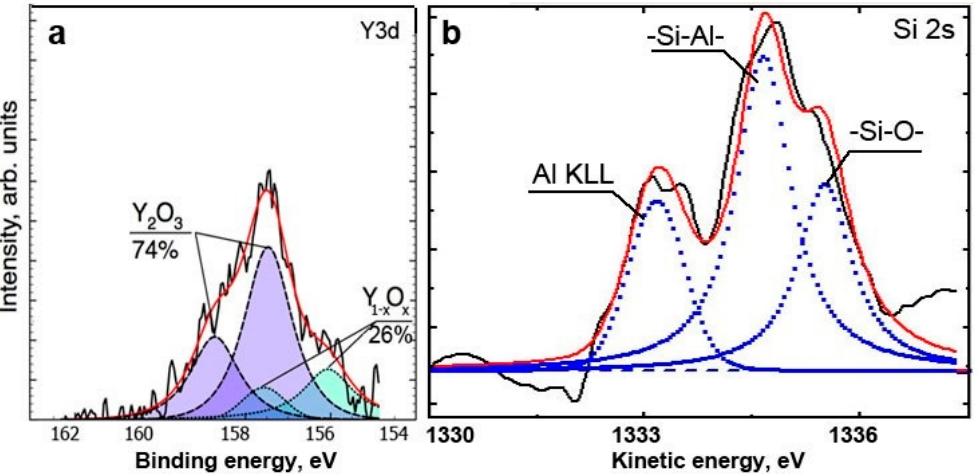
Figure 7. HR XPS Y3d ( a ) and Si2s ( b ) photoelectron spectra of worn surface of multilayer TiAlCrSiYN / TiAlCrN coating—within running-in stage of wear (after length of cut of 15 m) [11].